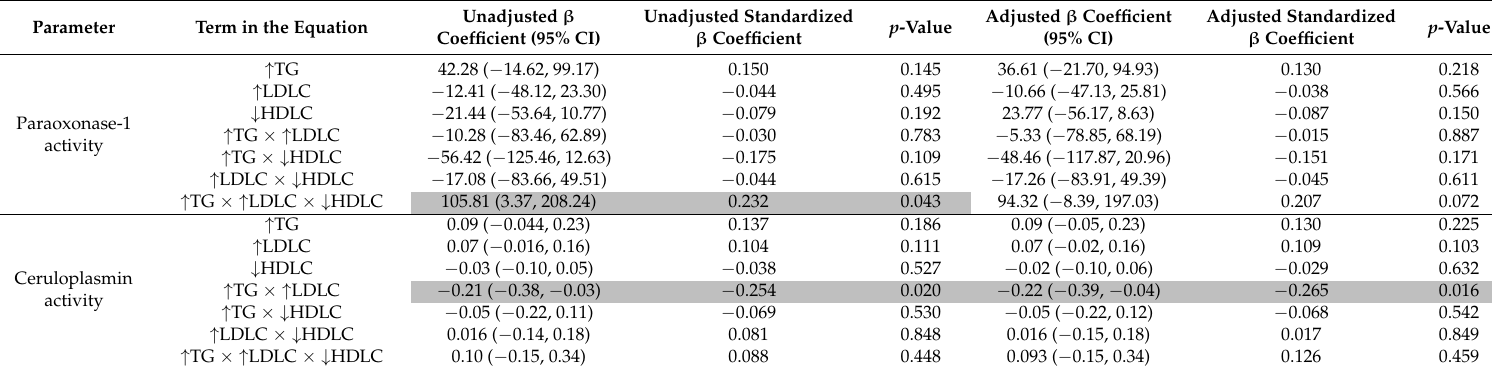
Shaded cells are those where p < 0.05. The adjusted β coefficient resulted from the linear models adjusted for all the covariates (age, gender, tobacco smoking, alcohol use, physical activity, and caloric